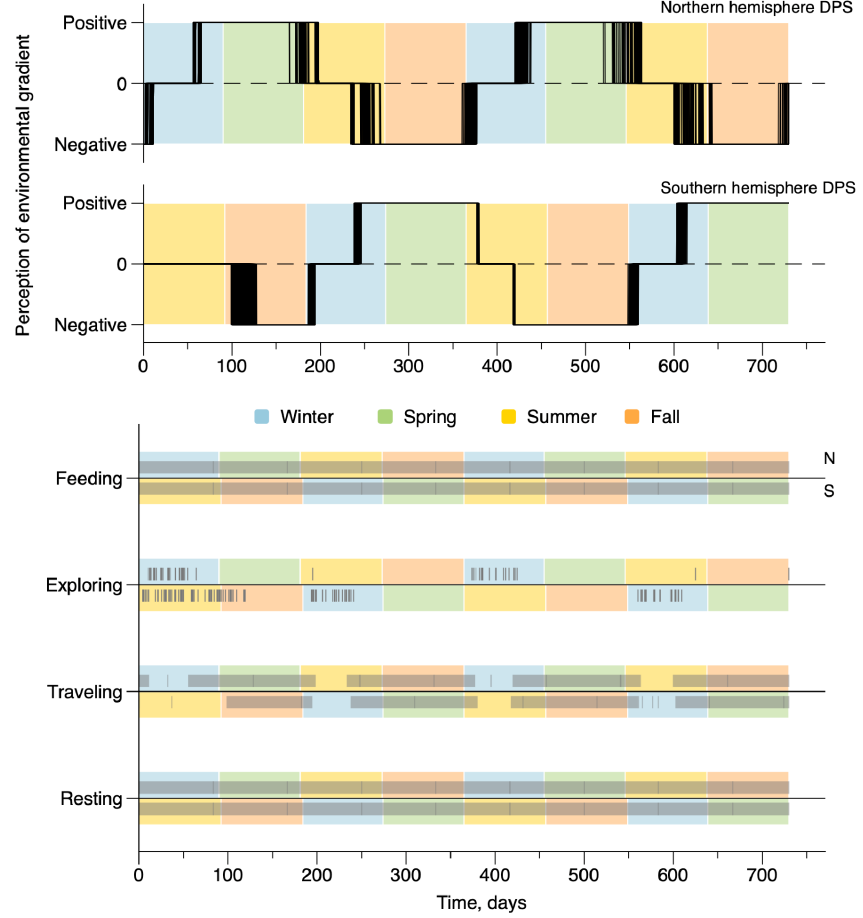
Figure 4. Time variations of the activity and behavior of whales in the constant depth with no coast configuration. The upper figure represents the realized perception of the environmental gradient defining the activity, superimposed on a seasonal cycle at mid-latitudes. When the perception was positive, whales migrated from low latitudes toward the poles, when the perception was negative, whales migrated from high latitudes toward the equator. The lower figure shows the occurrences (black lines) of the four behaviors superimposed on a seasonal cycle at mid-latitudes.